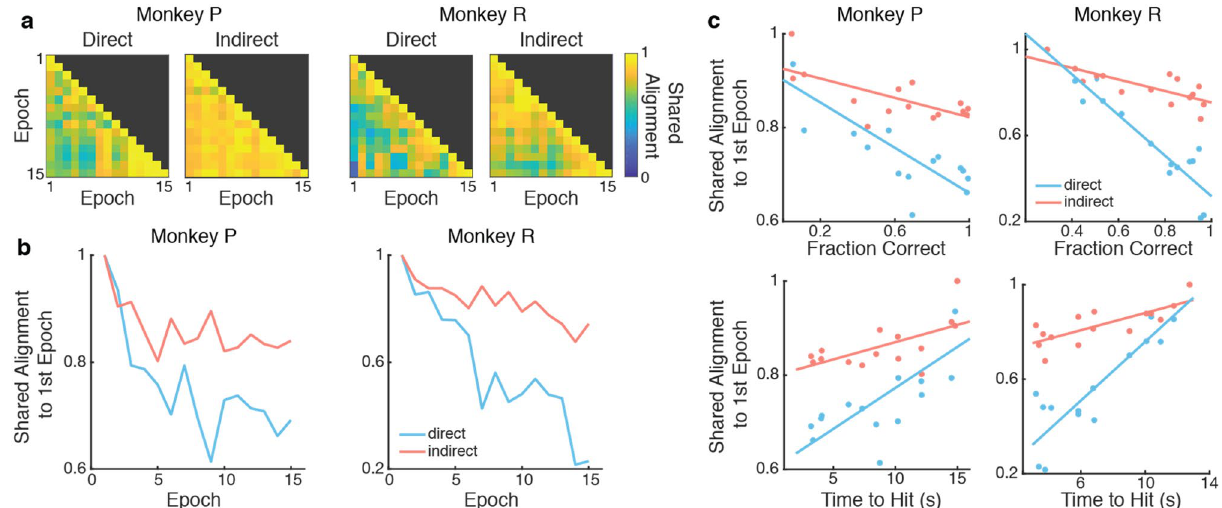
Figure 4. Rotation of low-dimensional neural subspace. ( a ) Shared alignment was calculated pairwise between epochs for each subpopulation. ( b ) Alignment diverges from the first epoch in both subpopulations (Linear regression; Monkey P: direct, R 2 = 0.530, p = 0.001, indirect, R 2 = 0.352, p = 0.012; Monkey R: direct R 2 = 0.857, p = 4.63e-7, indirect R 2 = 0.760, p = 1.41e-5). The slopes for direct and indirect shared alignment across epochs were significantly different (One-way ANCOVA; Monkey P: p = 0.024; Monkey R: p = 5.84e-6). ( c ) Alignment is correlated with fraction correct (Top, linear regression; Monkey P: direct, R 2 = 0.657, p = 2.0e-4, indirect R 2 = 0.481, p = 4.2e-4; Monkey R: direct R 2 = 0.870, p < 1.0e-6, indirect R 2 = 0.589, p = 8.0e-4) and time to hit (Bottom, linear regression; Monkey P: direct, R 2 = 0.535, p = 0.002, indirect R 2 = 0.380, p = 0.014; Monkey R: direct R 2 = 0.815, p < 1.0e-6, indirect R 2 = 0.592, p =